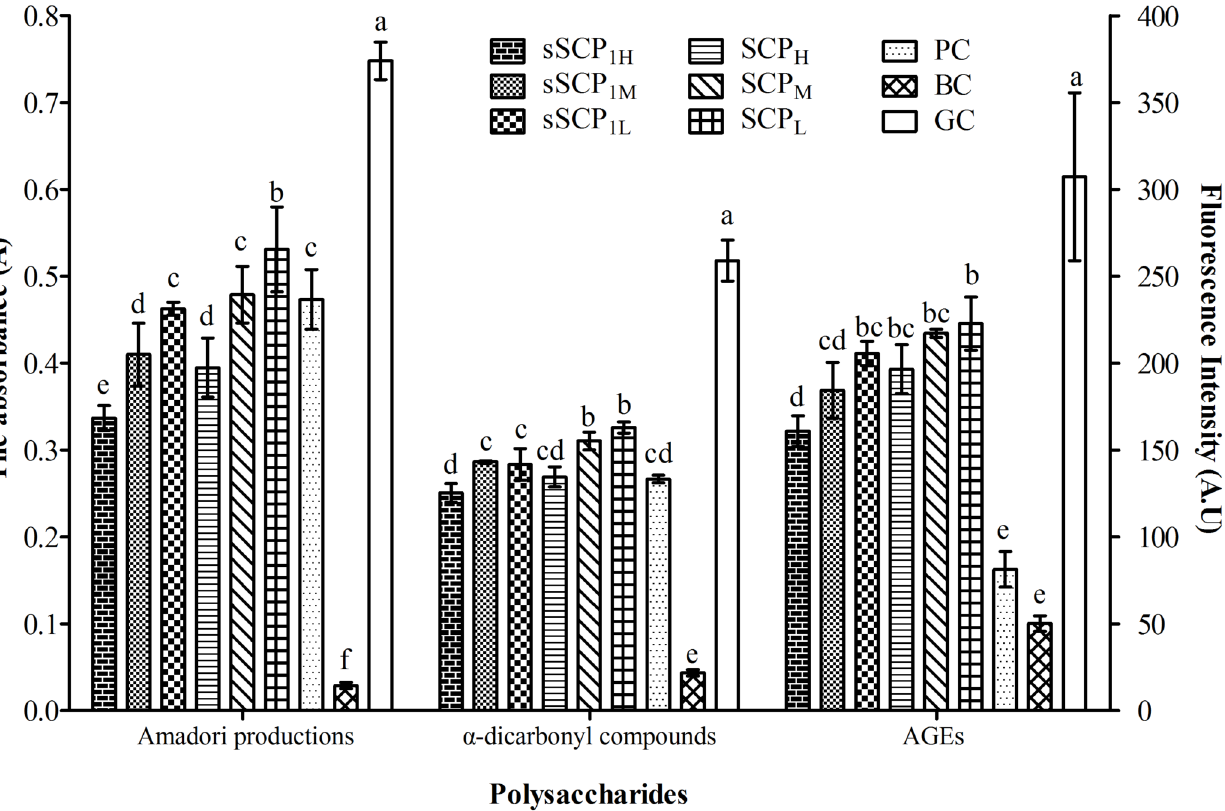
Fig 6. The absorbance of Amadori products and α -dicarbonyl compounds and the relative fluorescence intensities of AGEs in each group. [sSCP 1L = BSA+Glu+sSCP 1 (0.25mg (cid:1) mL -1 ); sSCP 1M = BSA+Glu+sSCP 1 (0.5mg (cid:1) mL -1 ); sSCP 1H = BSA+Glu+sSCP 1 (1mg (cid:1) mL -1 ); SCP L = BSA+Glu+SCP (0.25mg (cid:1) mL -1 ); SCP M = BSA+Glu+SCP (0.5mg (cid:1) mL -1 ); SCP H = BSA+Glu+SCP (1mg (cid:1) mL -1 ); PC = BSA+Glu+AG; BC = BSA+PBS; GC = BSA+Glu]. Bars in same concentration without same superscripts (a – f) differ significantly ( P <